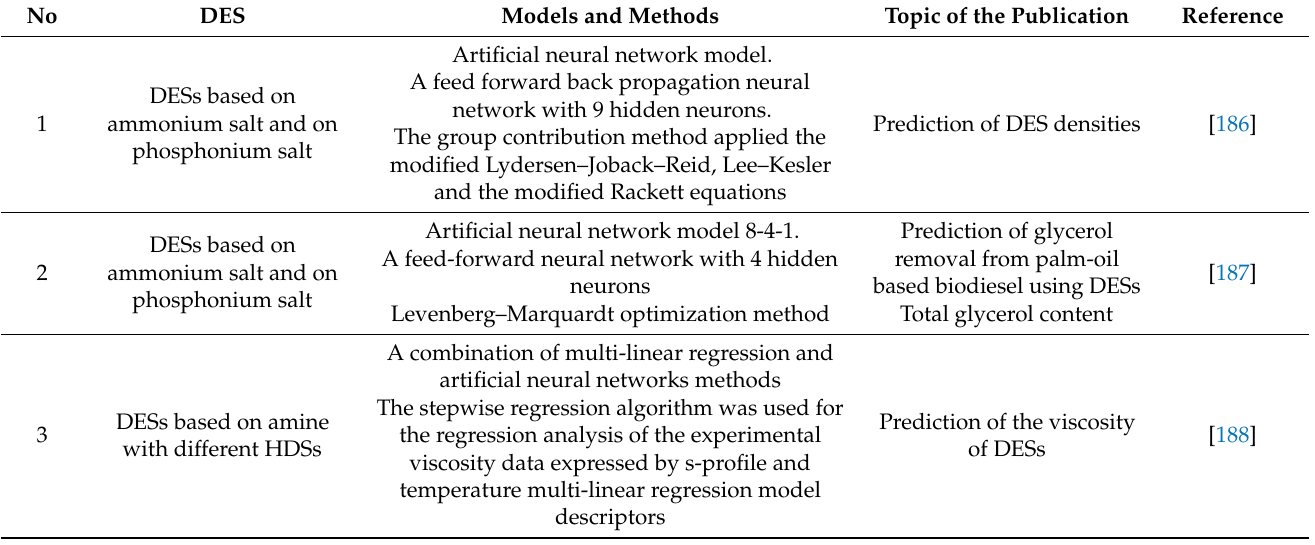
Table A3. Machine Learning calculations of DES consisting systems, used method and model, and the topic of the